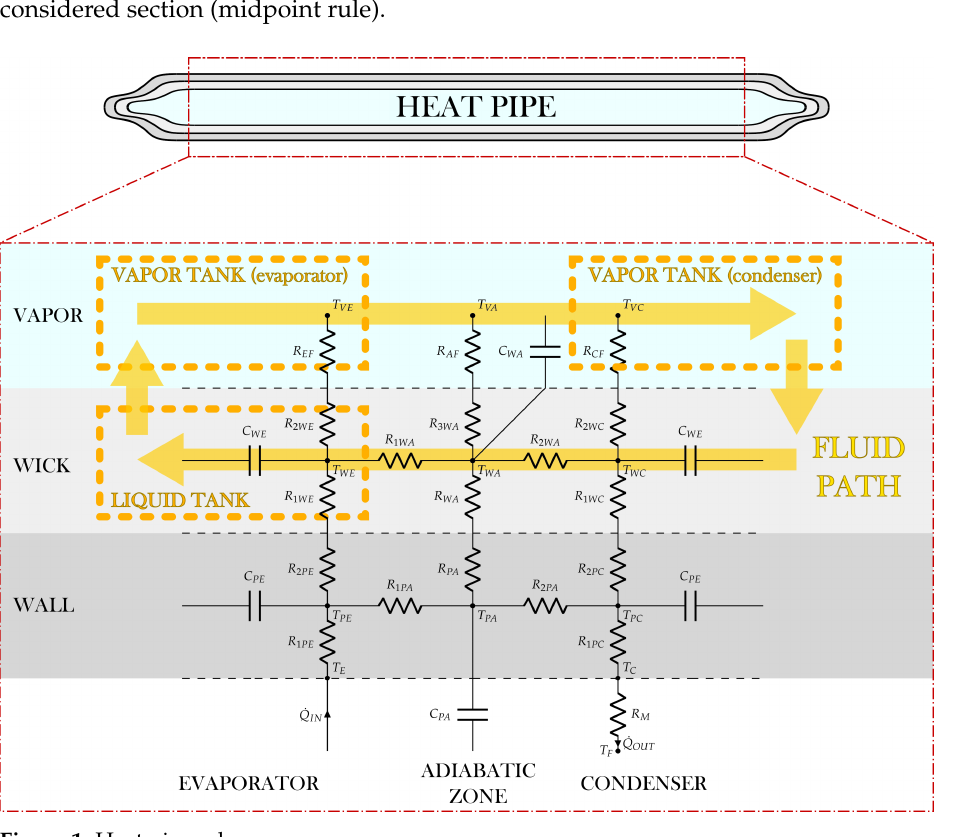
Figure 1. Heat pipe